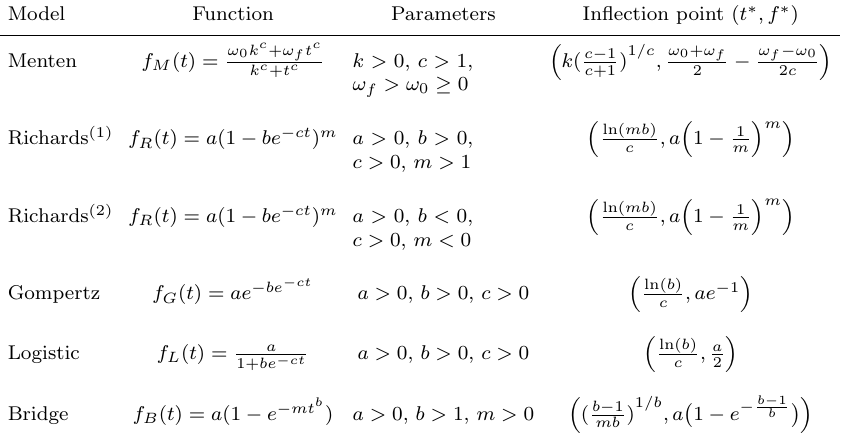
Table 1. Parameter values and inflection point of the growth models.